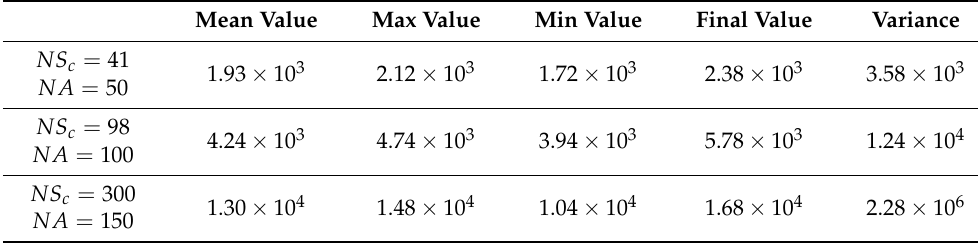
Table 2. Initial population distribution with different